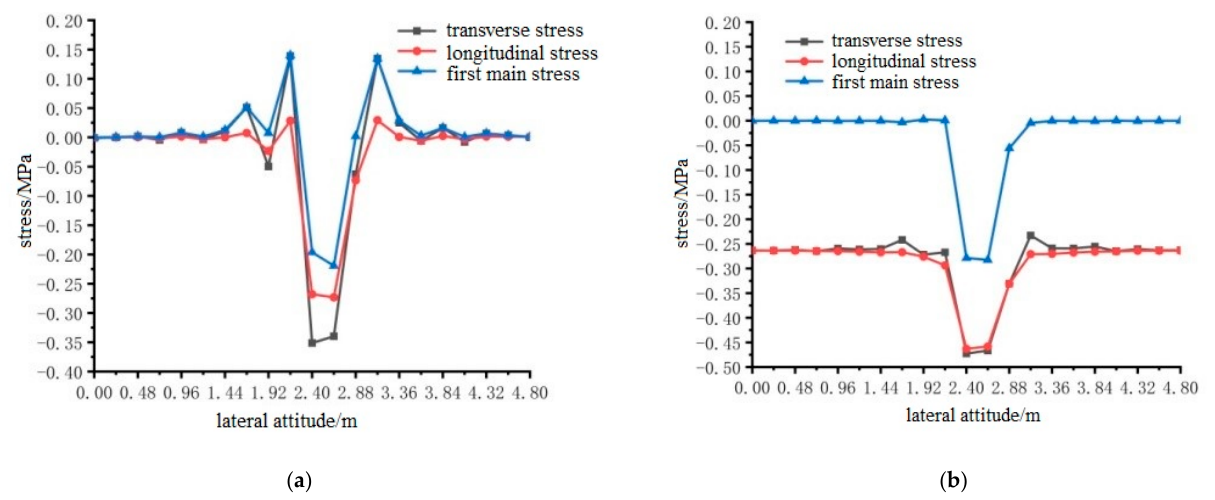
Figure 25. The transverse distribution of longitudinal and transverse stress on the surface of the pavement layer with and without temperature field under the action of load level 2. ( a ) Longitudinal and transverse stress diagrams without temperature field; ( b ) Longitudinal and transverse stress diagrams with temperature field effect.